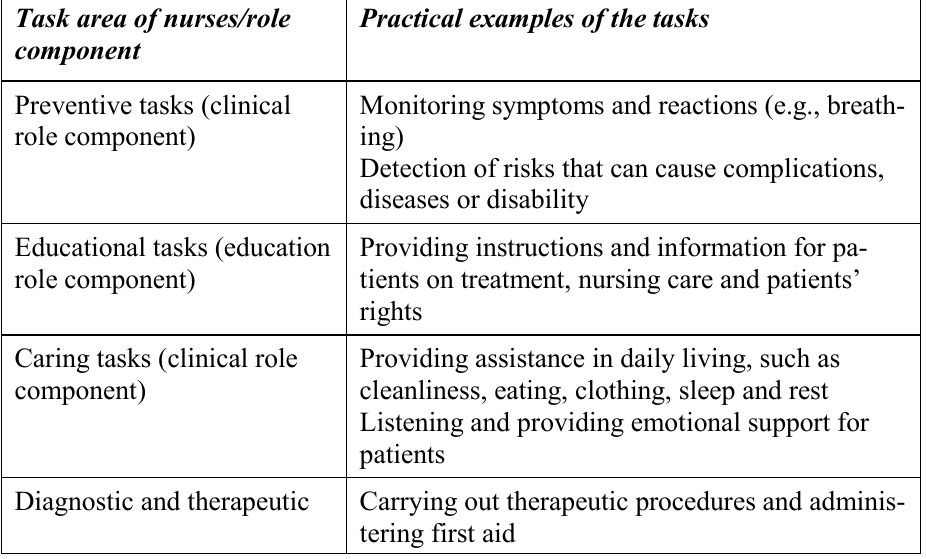
Common nursing work tasks areas with practical examples Task area of